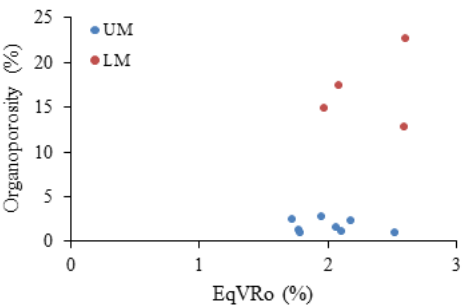
Figure 9. Relationship between total porosity and equivalent vitrinite reflectance (EqVR o ).